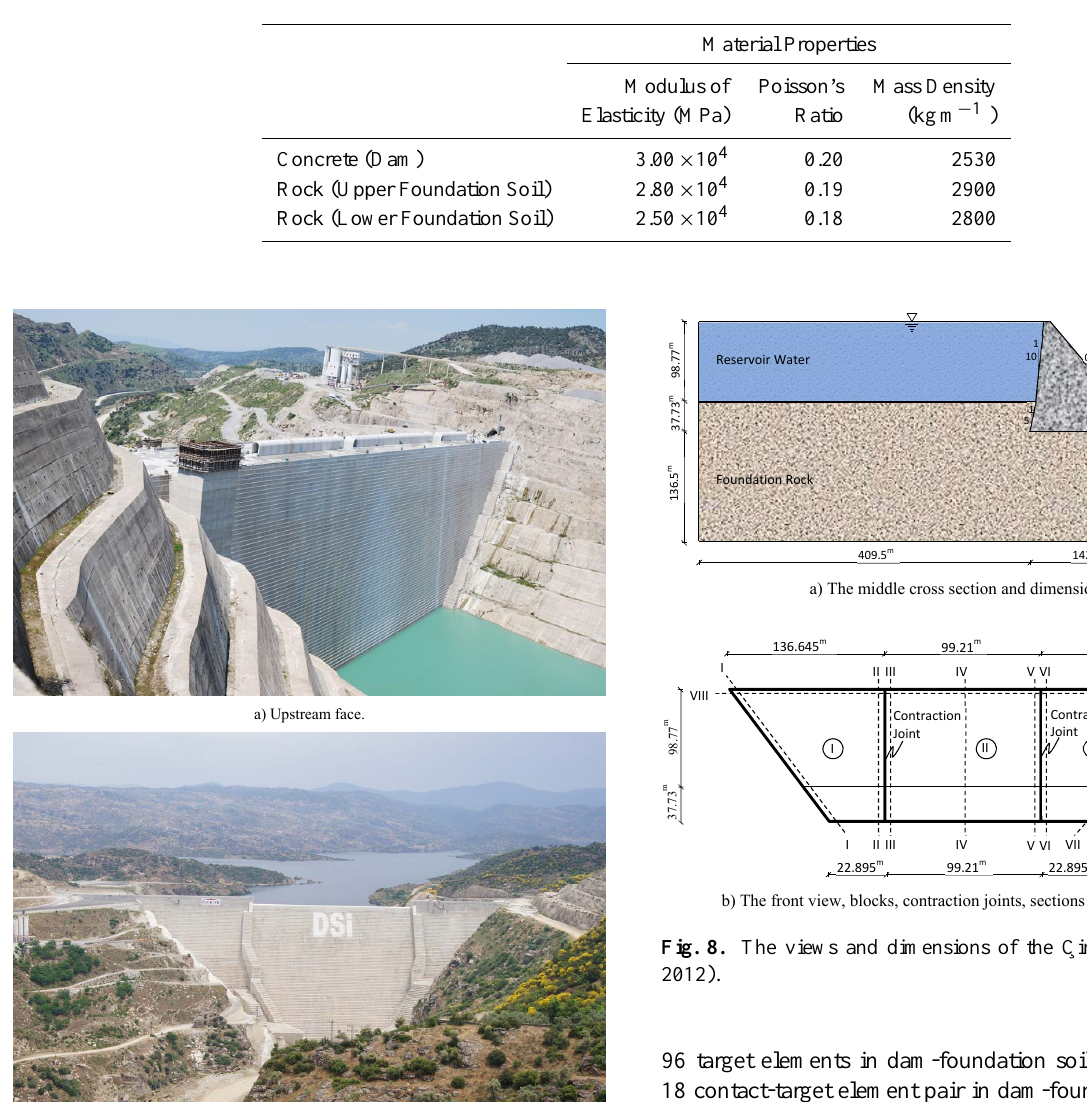
analysis have four nodes and 2 × 2 × 2 integration points; the fluid finite elements (Fluid80) have four nodes and 1 × 1 × 1